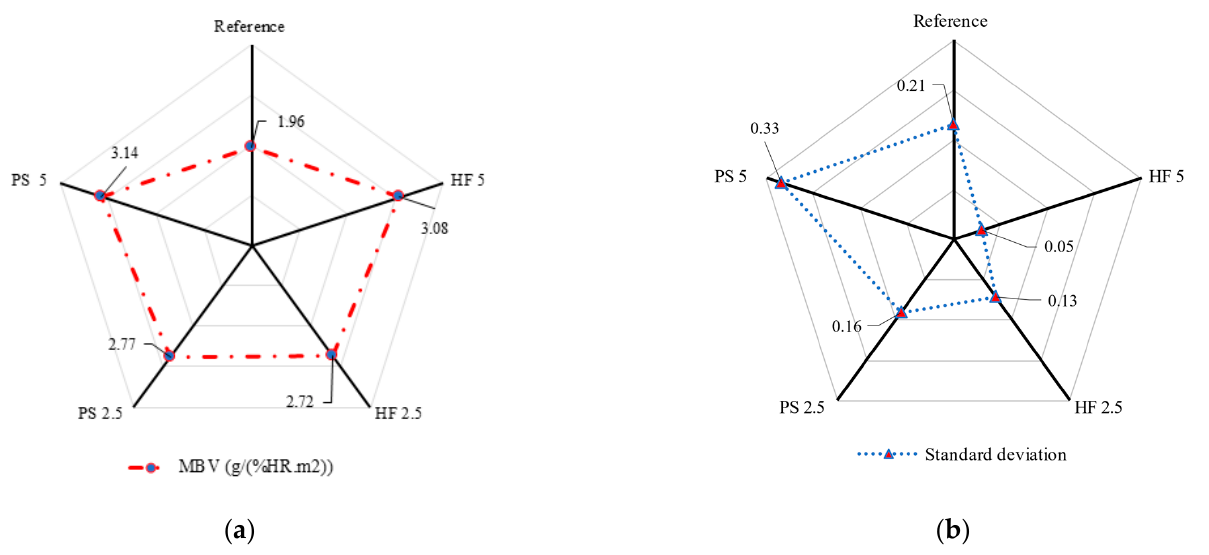
Figure 10. ( a ) Moisture buffer value (MBV) of fiber mortar; ( b ) standard deviations.